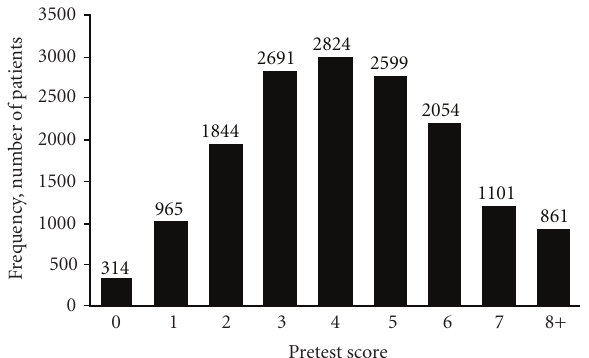
Figure 3: Distribution of pretest scores in the cohort of 15,253 patients. “8+” indicates an individual score of 8, 9, 10, or 11.